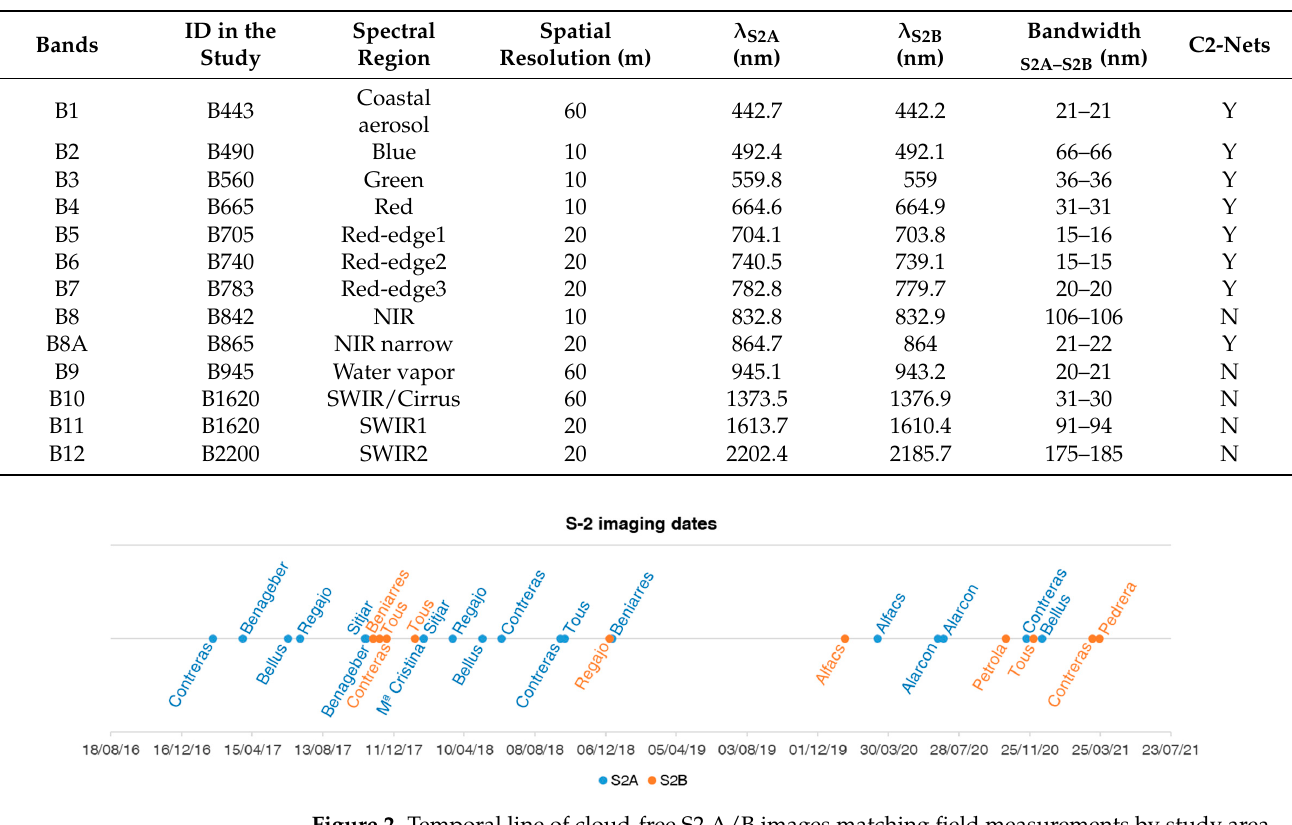
Table 3. S2A and S2B spectral bands, central wavelength ( λ ), spatial resolution, and application. Data from Copernicus Sentinel-2 MSI user guide [22]. The field ‘C2-Nets’ indicates the spectral bands outputted by C2-Nets (Y = yes, N = no).